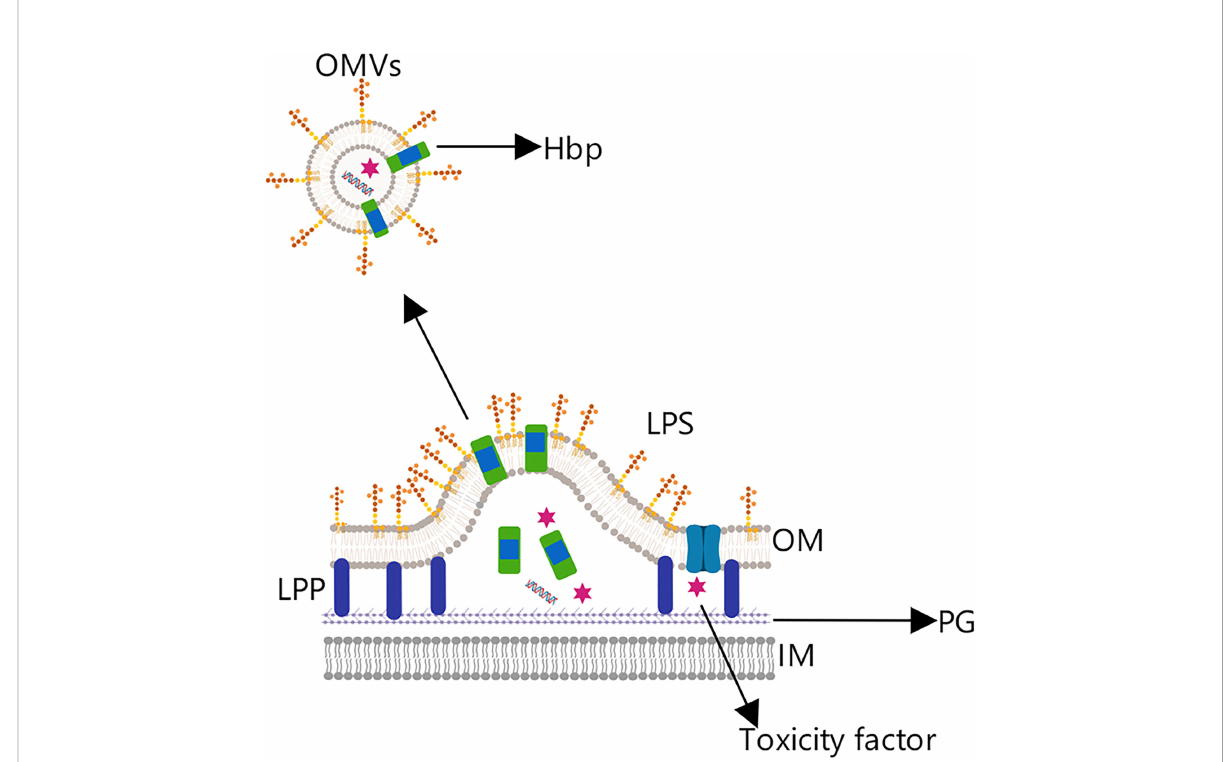
FIGURE 8 OMV tumor vaccine based on the hemoglobin protein. Hemoglobin protein (Hbp) is a virulence factor in Gram-negative bacteria that is transported to the outer membrane by the self-transport